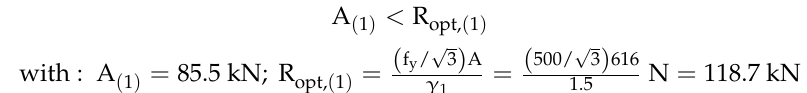
Figure 4. Scheme of the equilibrium problem for the proofs of safety of the protection system assumed. Top: equilibrium problem for proofs of safety 1, 2 and 3; Bottom: equilibrium problem for proofs of safety 4 and 5. Destabilising and stabilising actions in the general equilibrium problem, as well as the forces in the nails, are marked in black; specific resulting actions A (i) and corresponding resistances R (i) to be considered for the proofs of safety are marked in red and green,